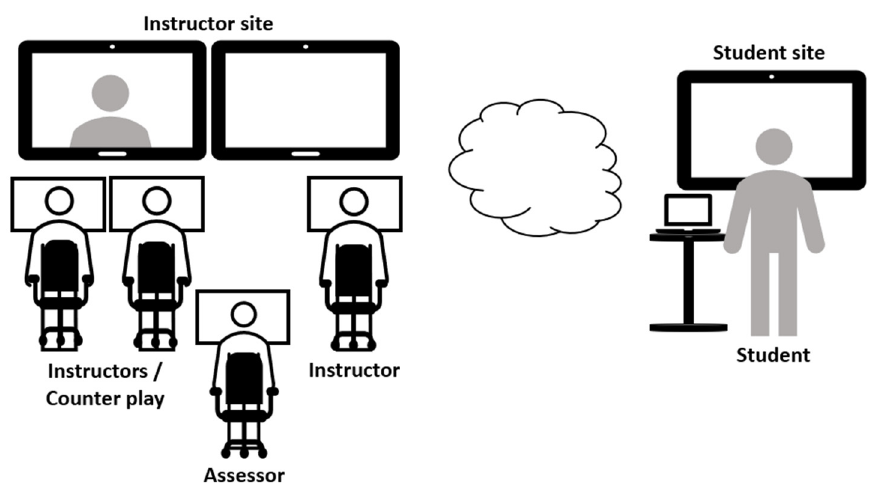
Figure 6. Schematic representation over the setup for RVS examination, where the student could participate from anywhere in the country.